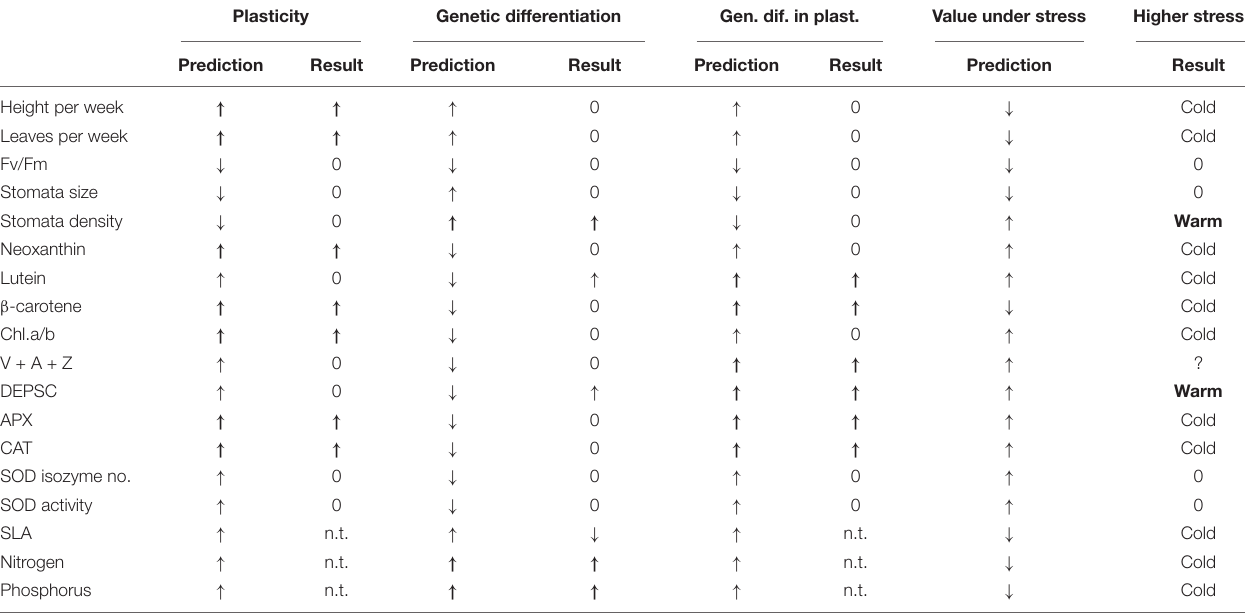
TABLE 1 | Summary of predictions and results of the degree of plasticity (effect of target climate), genetic differentiation (effect of climate of origin) and their interaction – genetic differentiation in plasticity. Plasticity Genetic differentiation Gen. dif. in plast. Value under stress Higher stress in Prediction Result Prediction Result Prediction Result